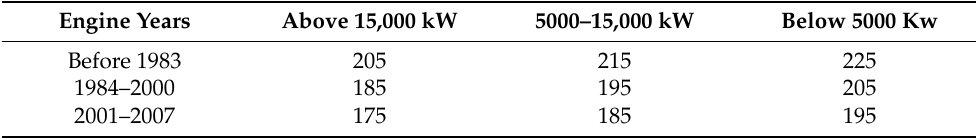
Figure 3. Procedure for the calculation of the spatial gas emission using the bottom-up approach. Table 3. SFOC values (g/kW h) of main